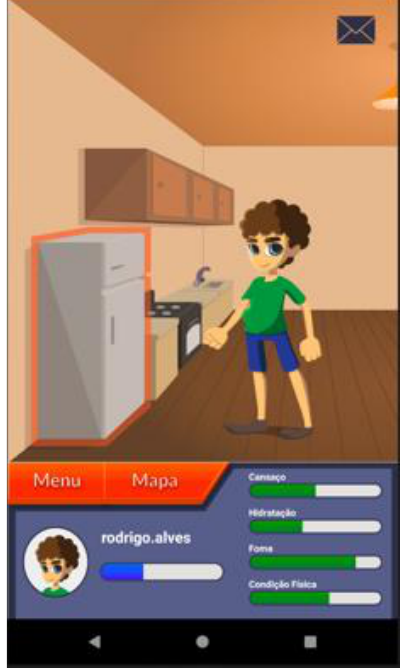
Figure 6. “Casa” Home section —presents the fatigue (“cansaço”); hydration (“hidratação”); hunger (“fome”) and physical condition (“condição física”)— affordance; consistency.